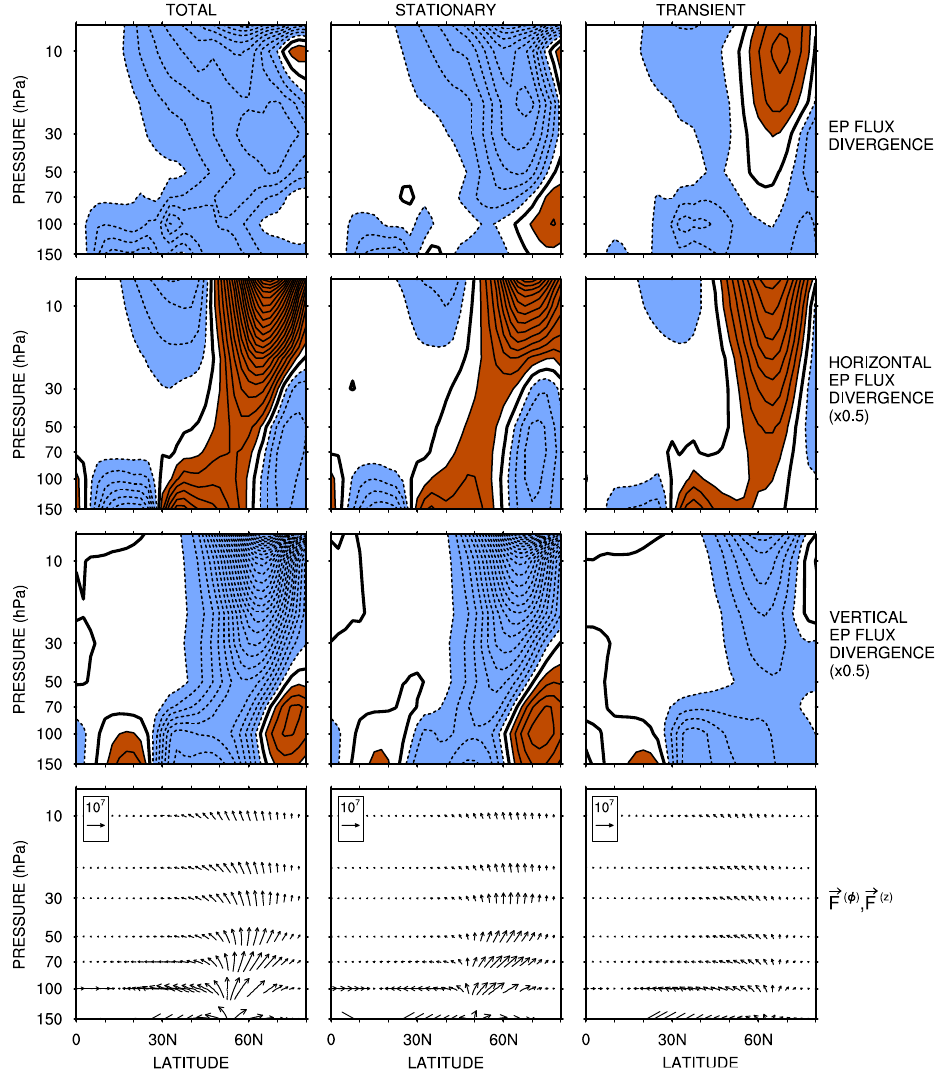
Fig. 5. Same as Fig. 2 but for the EP flux divergence, its horizontal and vertical components, and the EP flux vector, including stationary and transient components. Contour interval is 0.5ms − 1 day − 1 for the EP flux divergence and its horizontal and vertical components. The reference vector corresponds to 10 7 kgs − 2 and the vertical component is multiplied by 100 for scaling purposes. Note that the horizontal and vertical components of the EP flux divergence are large compared to the EP flux divergence and are therefore multiplied by